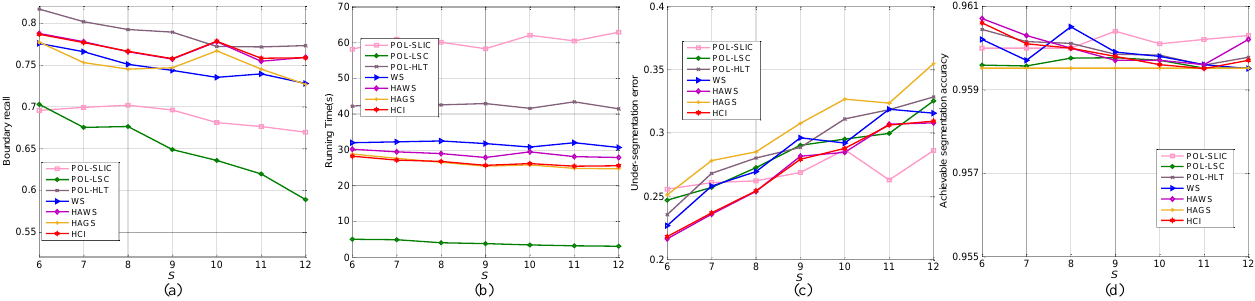
Figure 13. Quantitative evaluation results based on the enlarged region A of the AIRSAR data set. ( a ) BR. ( b ) RT(s). ( c ) USE. ( d )